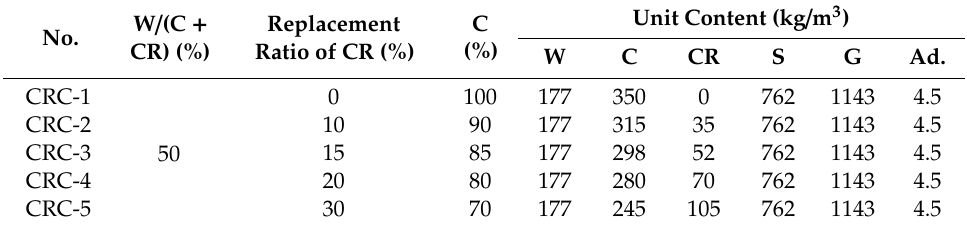
Table 4. Mix proportions of di ff erent concrete single-added petroleum coke residue.